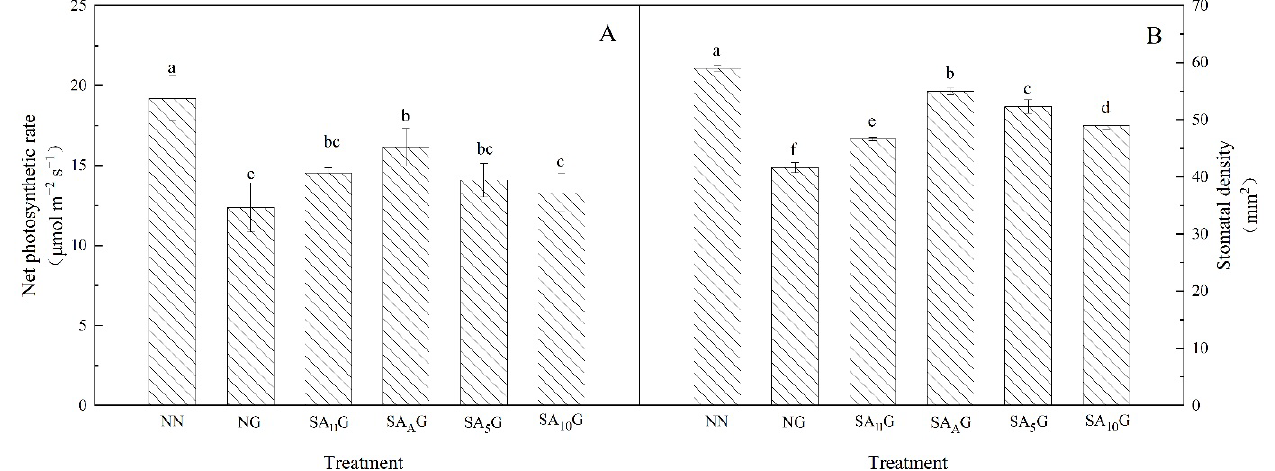
Figure 4. Effect of exogenous salicylic acid (SA) spraying on the net photosynthetic rate ( A ) and stomatal density ( B ) of the flag leaves of wheat under high temperature stress at the grain-filling stage (20 days after anthesis) in 2018–2019. NN is the control (normal growth conditions outside the shed). NG represents non-SA spraying and high temperature stress at the grain-filling stage. SA H G represents exogenous SA spraying at the heading stage and high temperature stress at the grain-filling stage. SA A G represents exogenous SA spraying at the anthesis stage and high temperature stress at the grain-filling stage. SA 5 G and SA 10 G represent treatments whereby exogenous SA was sprayed starting from 5 and 10 DAA and high temperature stress at the grain-filling stage. Different lowercase letters denote statistically significant differences ( p < 0.05, Duncan’s multiple range test) among treatments. Results are expressed as mean ± SE ( n =